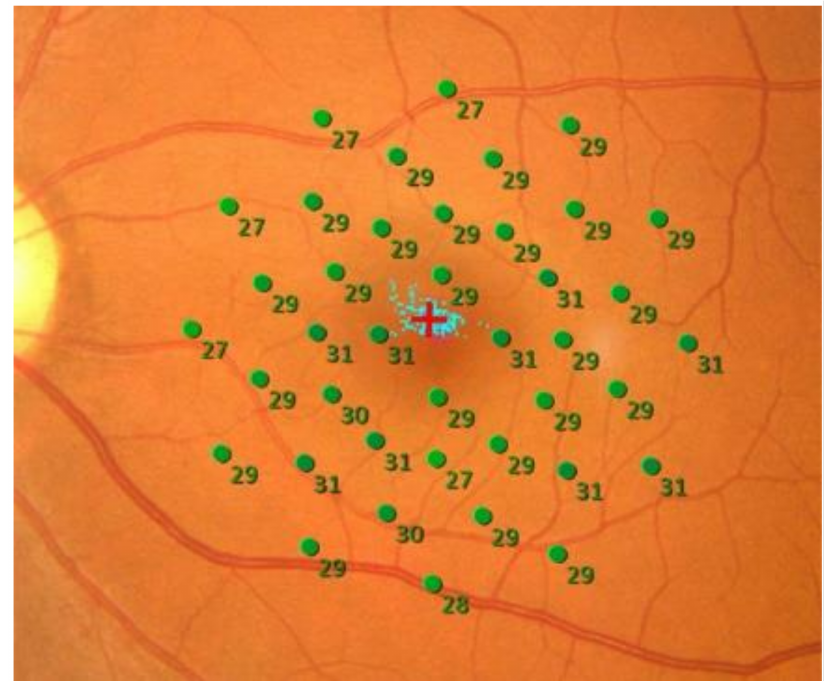
Figure 1. Retinal sensitivity in a normal eye. Retinal sensitivities measured by MP-3 were above 27 dB at all measurement points and are displayed in green. The 16 degrees—40 points pattern with background luminance 31.4 asb was used. The average retinal sensitivity in the central 20 ◦ is 28.5